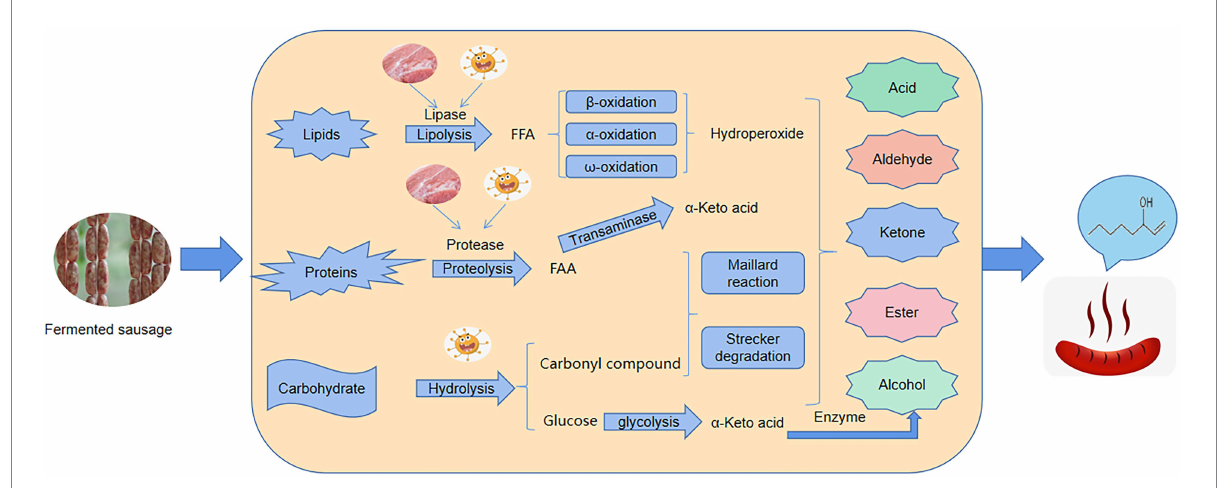
FIGURE 7 The schematic diagram of mechanism of microorganisms on the formation of flavor substances in fermented